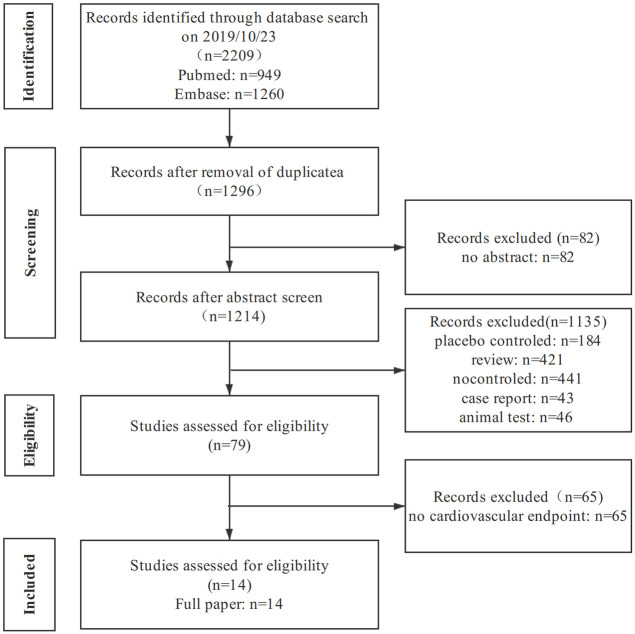
Screening process of included studies.